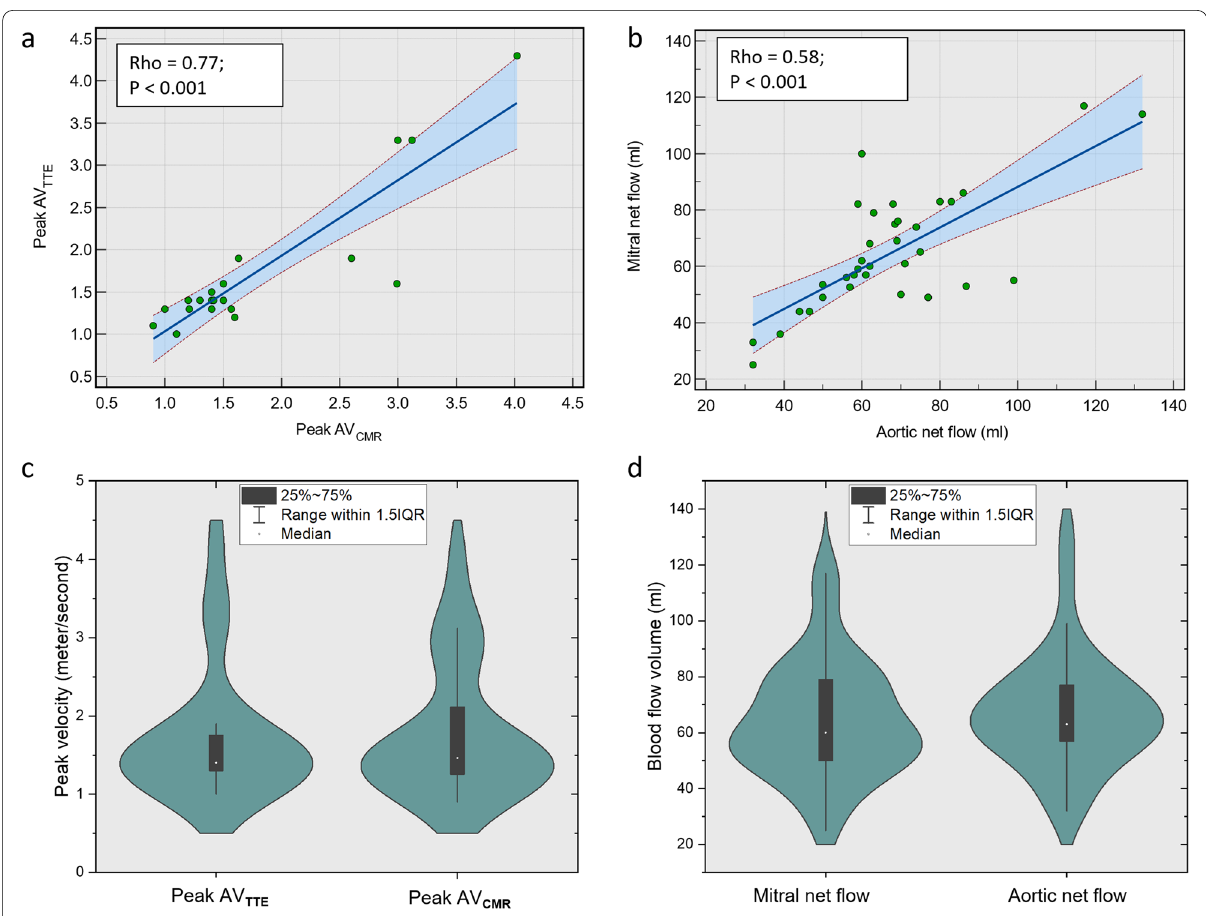
Fig. 3 a , b Scatter plots with 95% confidence interval demonstrating a correlation between mitral and aortic flows and peak velocity through the aortic valve by echocardiography and four‑dimensional flow cardiovascular magnetic resonance ( a , b ). Violin‑plot showing minimal differences between each group ( c , d )